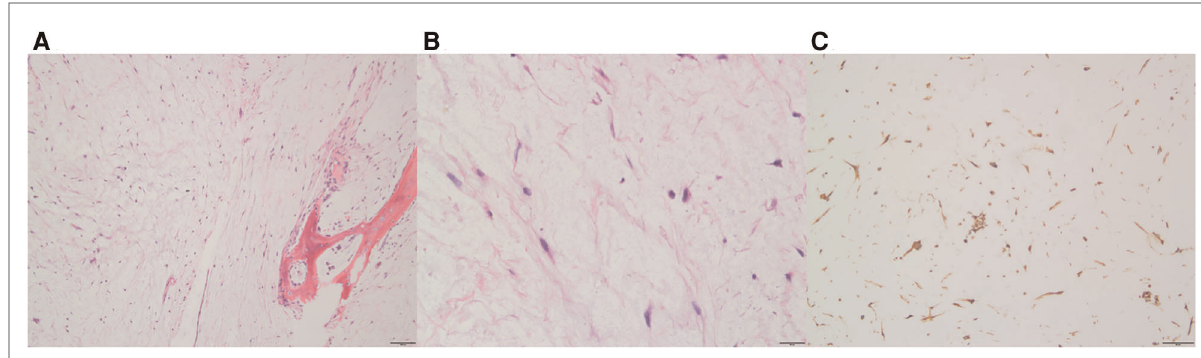
FIGURE 4 After the second operation, Hematoxylin-eosin (HE) staining and immunohistochemistry of the tumor. Thin-walled blood vessels surrounded by several spindle cells can be seen in the images ( A : 10×, B : 40×); In immunohistochemistry, vimentin was positive ( C